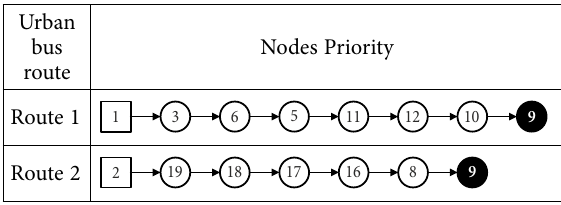
Table 2. New urban bus routes designed in scenario 1 Urban bus